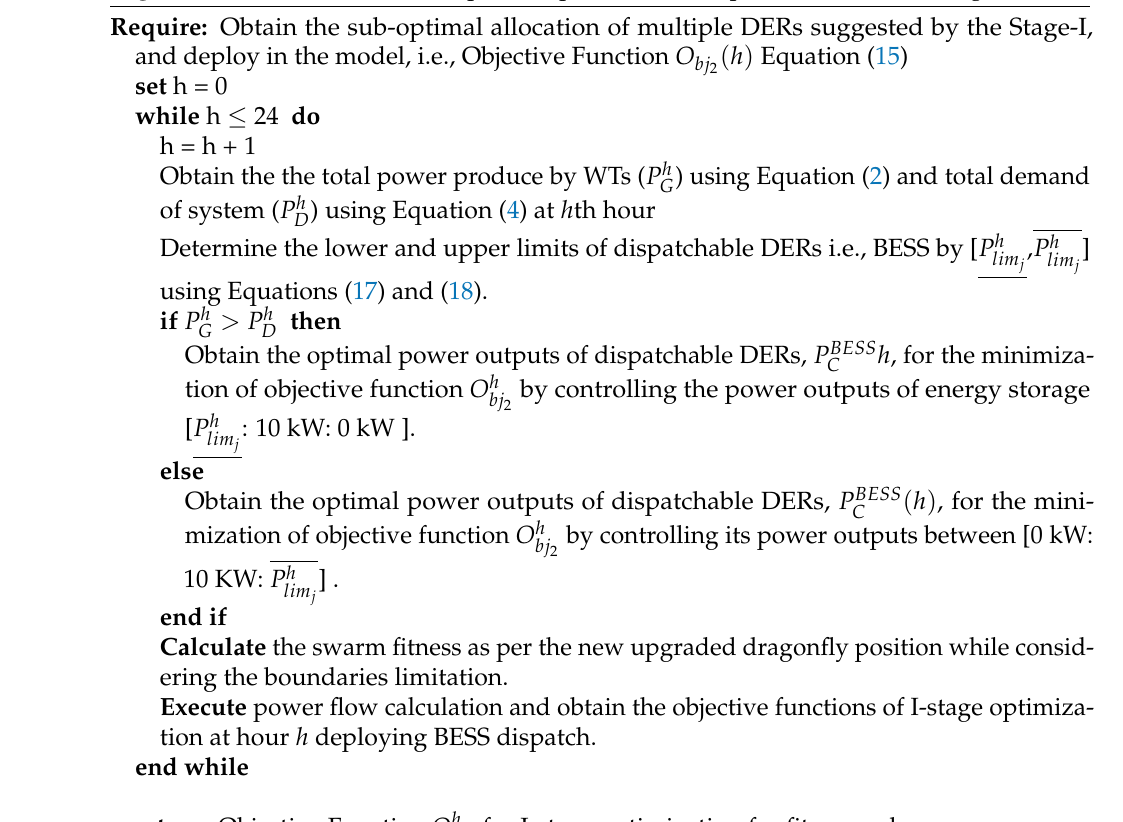
Algorithm 1 Pseudo Codes for optimal operations of dispatchable DERs in